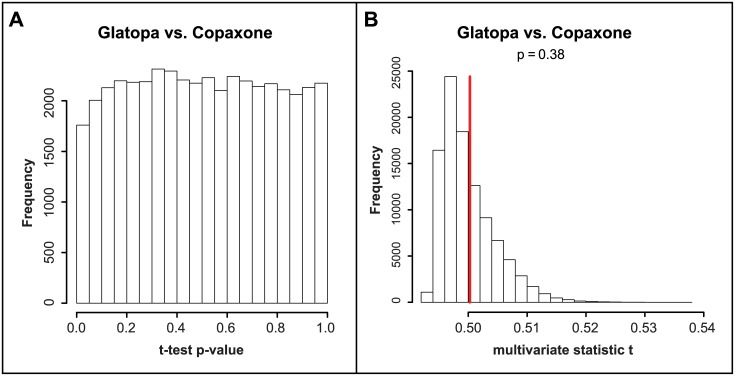
Statistical comparisons between Copaxone and Glatopa based on all probes.
A: distribution of t-test P-values across all array spots. The proportion of small P-values (P < 0.05) is small and the largest obtained q-value is greater than 0.99. B: multivariate statistic t (MVT) results. The observed value of MVT for Copaxone vs Glatopa is not significantly large as compared to values expected when randomly mixing samples between these two groups (P = 0.38).